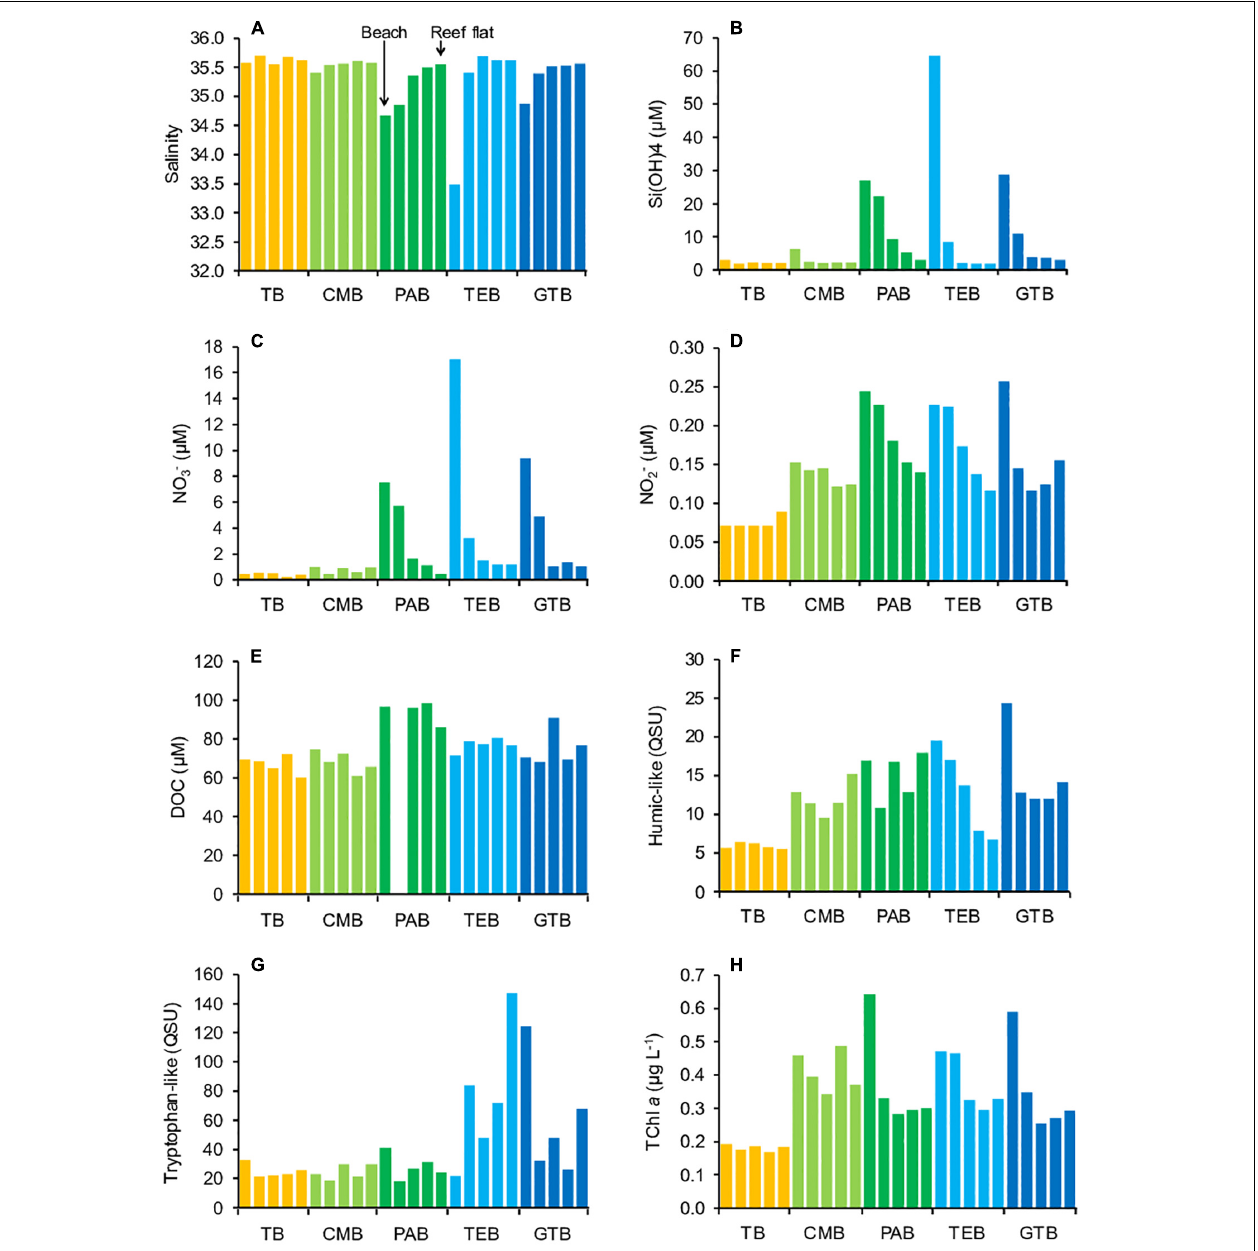
FIGURE 3 | Distribution of salinity and biogeochemical parameters in back reef waters from north (TB) to south (GTB) (A–H) . TB: Toboggan, including TB1-five samples (orange); CMB: Club Med, including CMB1-five samples (light green); PAB: Planch’Alizés, including PAB1-five samples (green); TEB: Trou d’Eau, including TEB1-five samples (light blue); GTB: Grand Trou d’Eau, including GTB1-five samples (blue); HB sample (Hermitage) is not included. For each site, from left to right: sample 1 (beach) to sample 5 (reef flat). PAB2 sample is missing for DOC. TChl a concentrations are derived from CTD measurements.